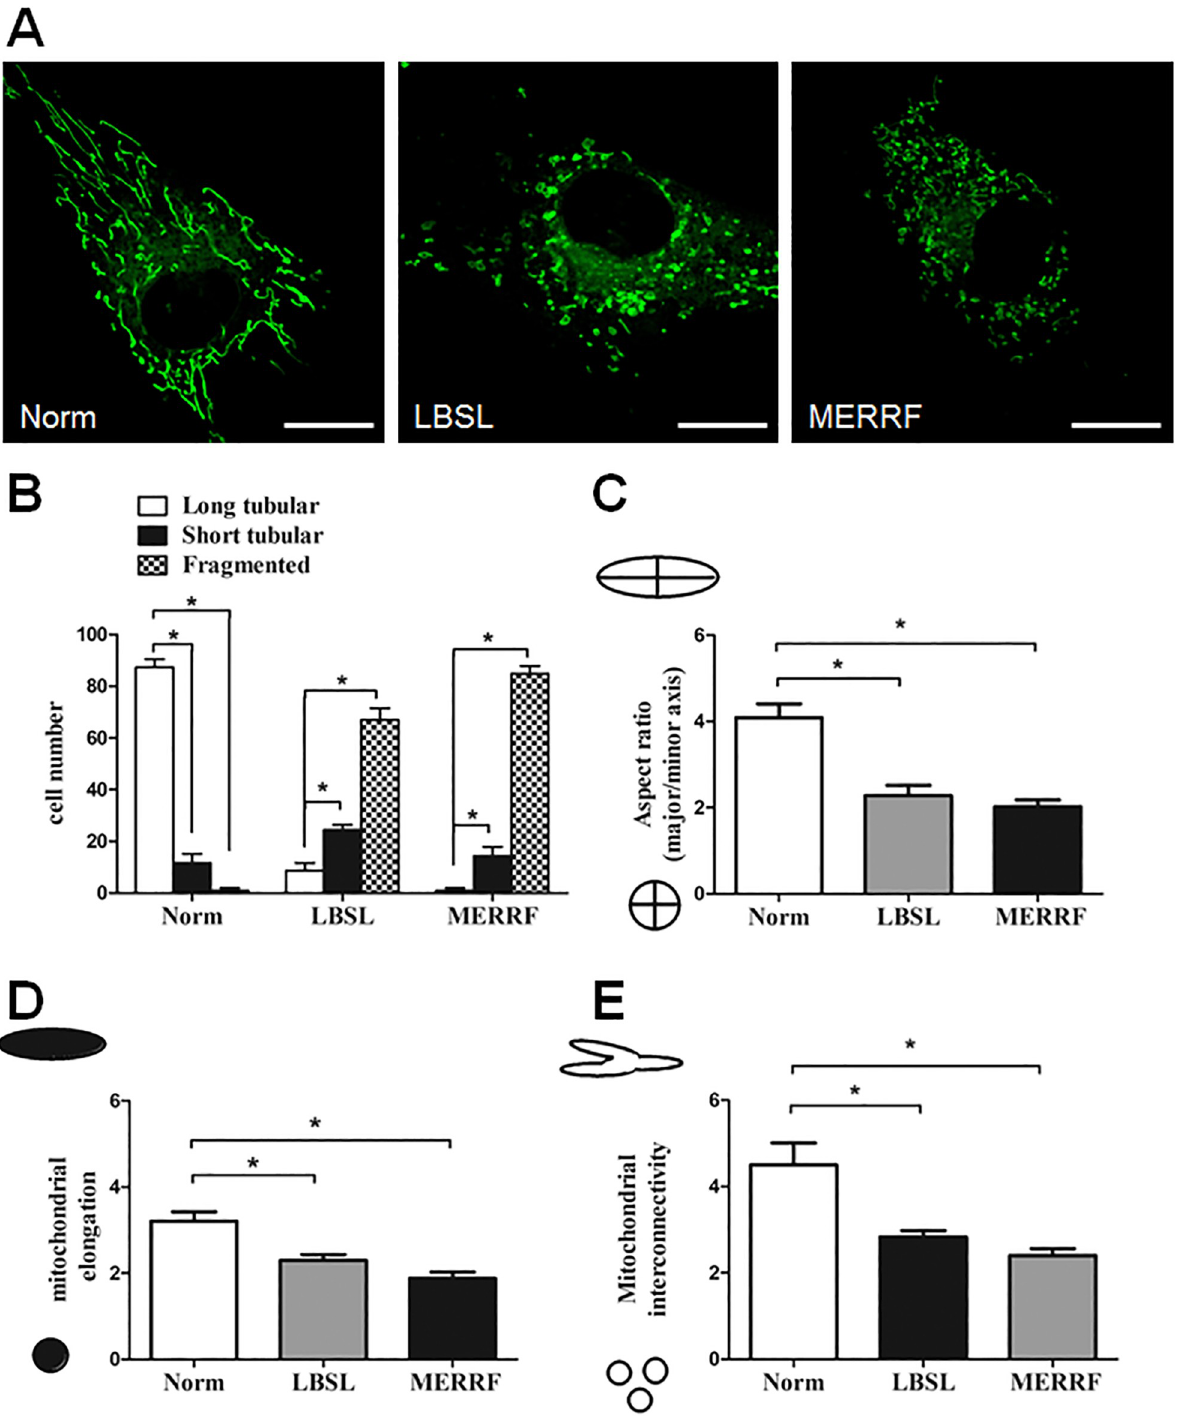
Fig 4. Cells with DARS2 defect present fragmented morphology of mitochondria. (A) Representative image of mitochondrial morphology. Scale bar, 10 μ m. (B-E) Mitochondrial morphology was analyzed using Dagda’s method, as described in Materials and Methods. � p < 0.05 between indicated